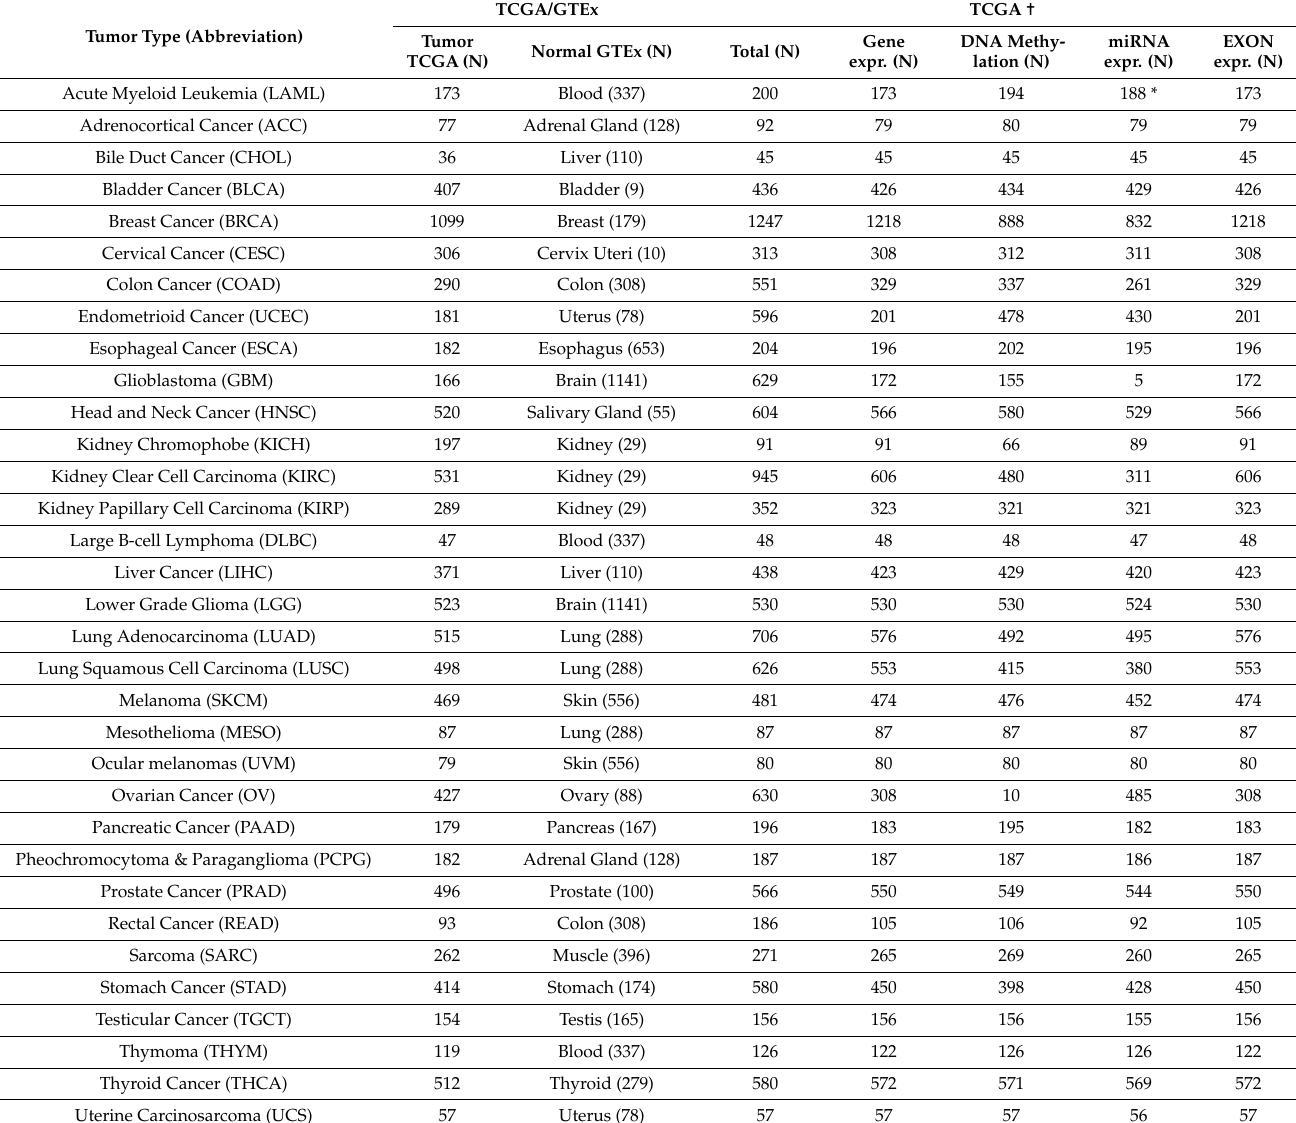
Table 3. TCGA and GTEx datasets and number of samples available in each dataset analyzed in this